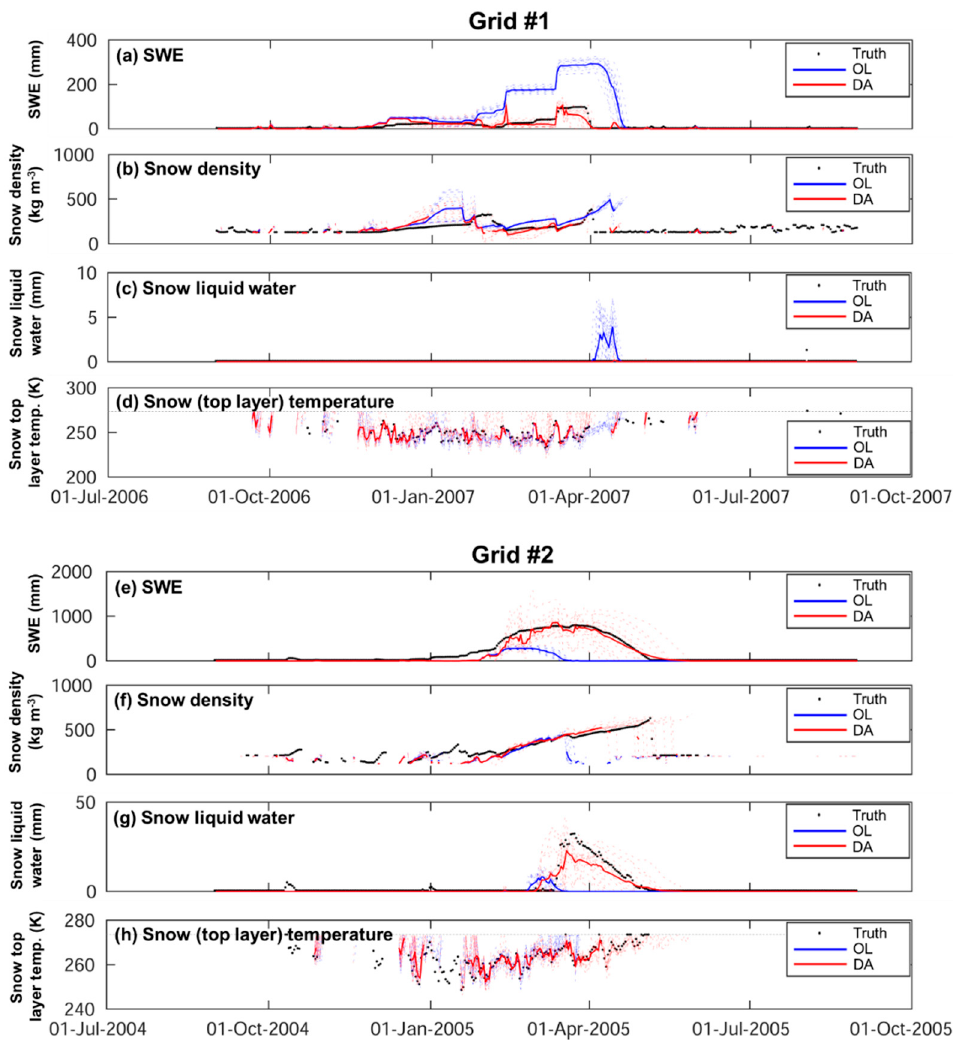
Figure 6. Time series of SWE ( a , e ), snow density ( b , f ), snow liquid water ( c , g ), and snow (top layer) temperature ( d , h ) including the synthetic truth (black dots), OL ensemble mean (blue line), and DA ensemble mean (red line) for Grid #1 and Grid #2. The dotted lines denote the ensemble range of the simulated snow states.